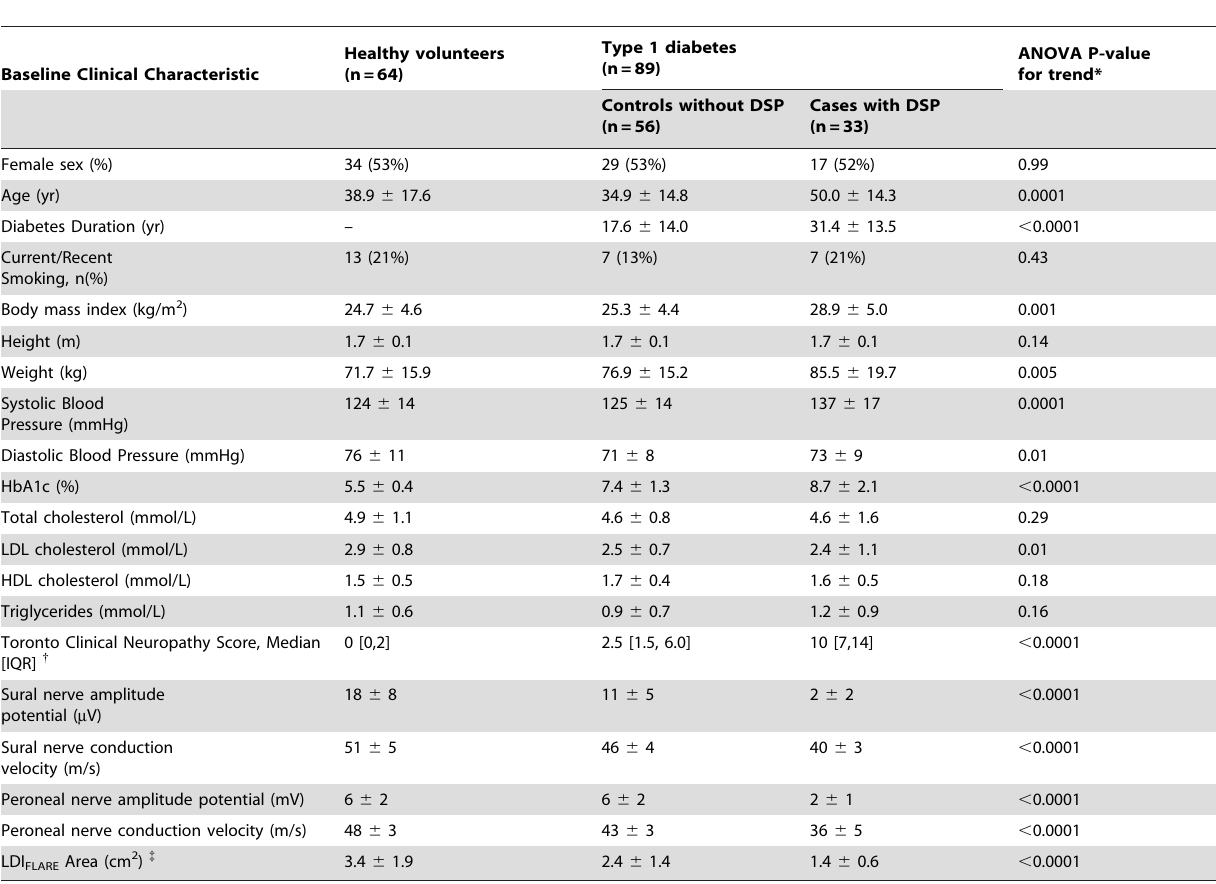
Table 1. Clinical characteristics of the 64 healthy volunteers and of the 89 type 1 diabetes participants according to diabetic sensorimotor polyneuropathy